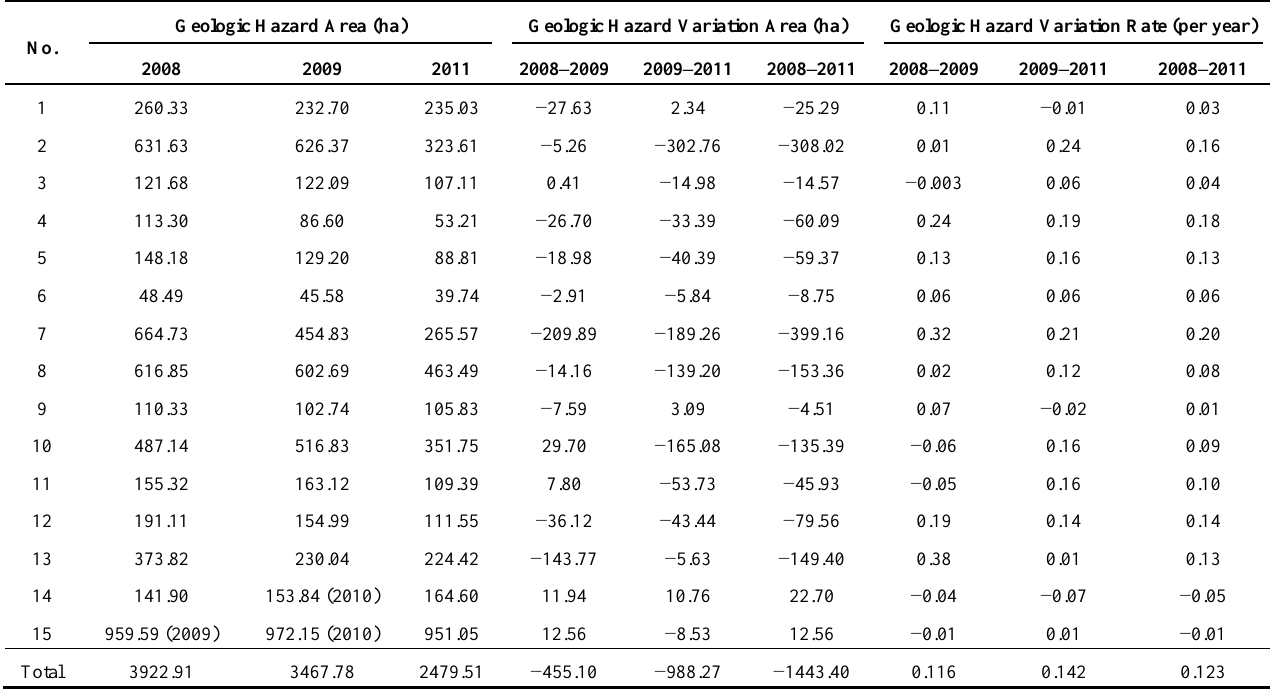
Table 3. Each site’s geologic hazard area and variation rate.